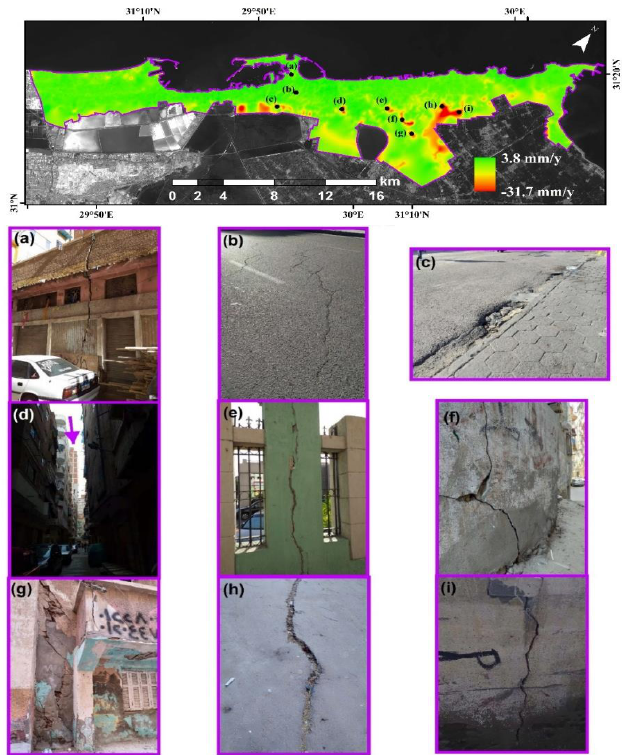
Figure 13. Samples of cracks on buildings and roads in high subsidence areas of Alexandria: The subsidence map shows locations of sub-figures; Figures a, e, f, g represent building and fences cracks, Figures b, c, h illustrate roads cracks, and d shows an example of high building tilts in subsidence areas.